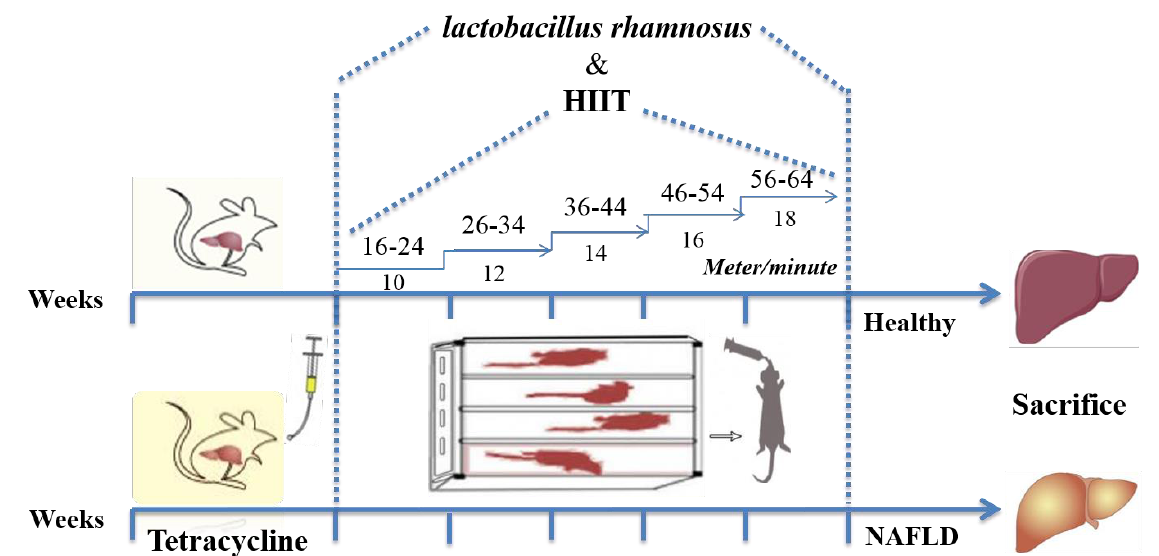
Figure 1: A protocol schematic detailing the timeline of all gavage and training visits Hepatic